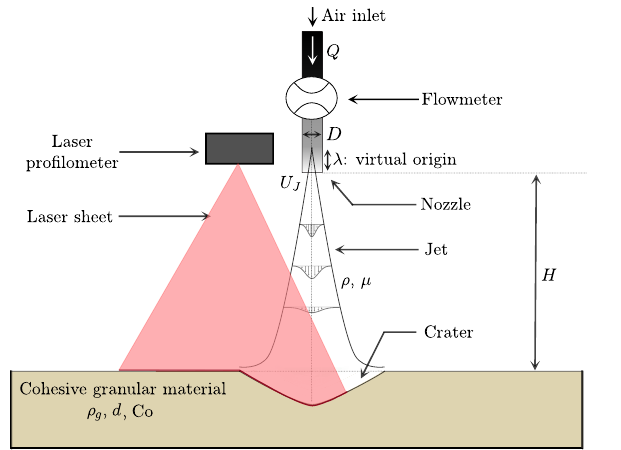
Figure 2. Mean velocity threshold of the jet at the outlet of the nozzle U J as a function of the distance between the nozzle and the granular bed H for glass beads of diameter d = 800 µ m and increasing cohesive number Co = 0 , 0 . 8 , 1 . 8 , 4 . 4 , 7 . 1 , 8 .